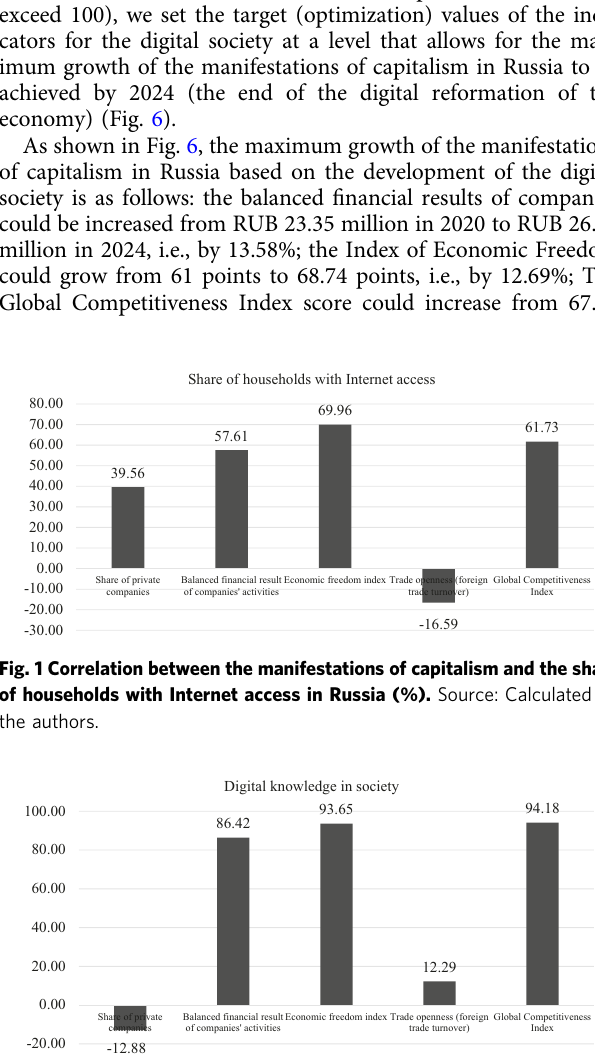
Fig. 2 Correlation between the manifestations of capitalism and digital knowledge in Russian society (%). Source: Calculated by the authors.